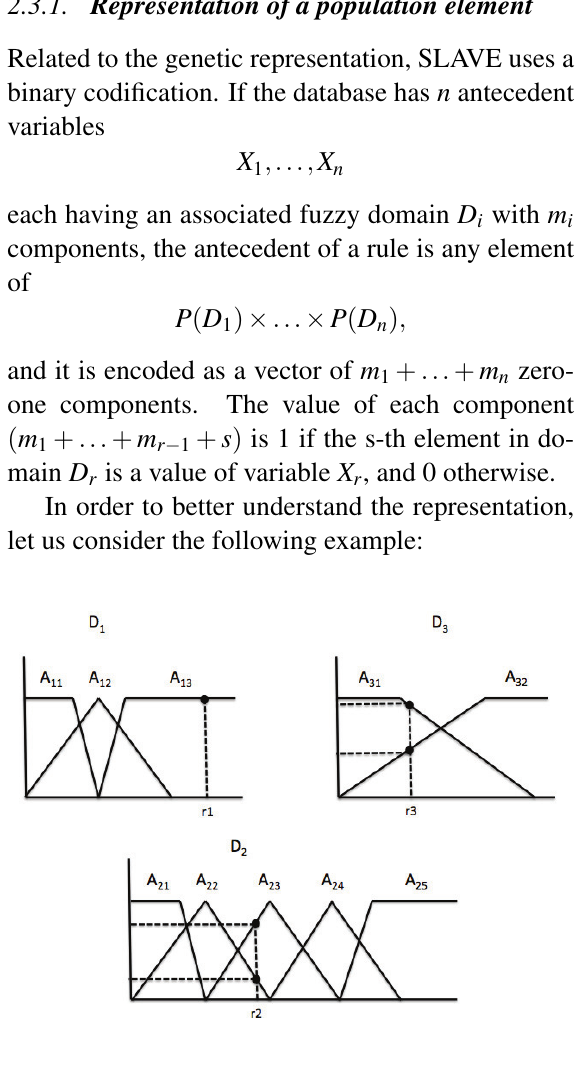
Fig. 2. Domains of variables X 1 , X 2 and X 3